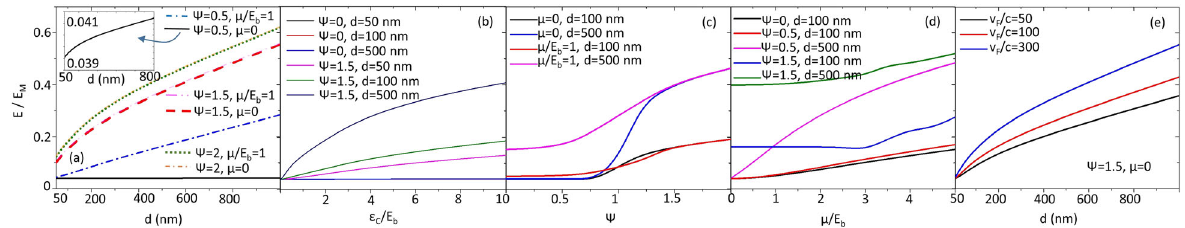
¼ (cid:3) π 2 _ c for two identical Weyl semimetals separated along the M 720 d 3